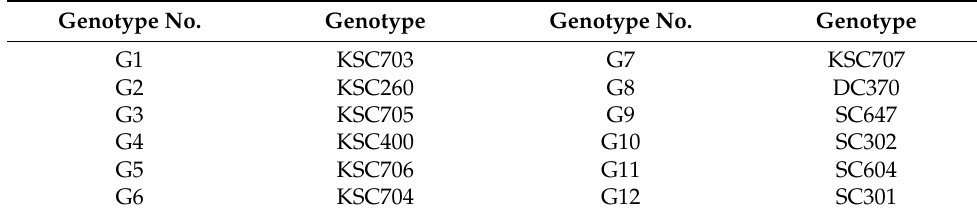
Table 2. Names and code of corn varieties studied in the experiment.